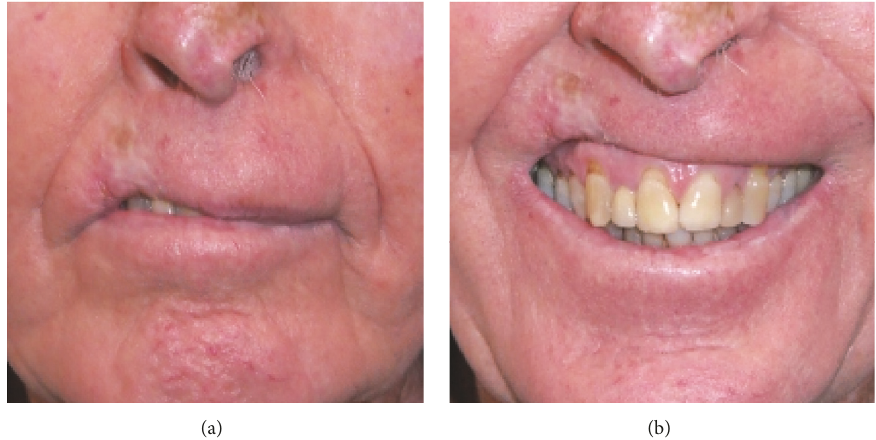
Figure 1: (a) Lip lesion treated successfully with definitive radiotherapy but with hypofractionation causing the late effects of hypopig- mentation, telangiectasia, and cicatrization. (b) The irradiated tissue does not move as well as the other tissue, ruining this gentleman’s smile.